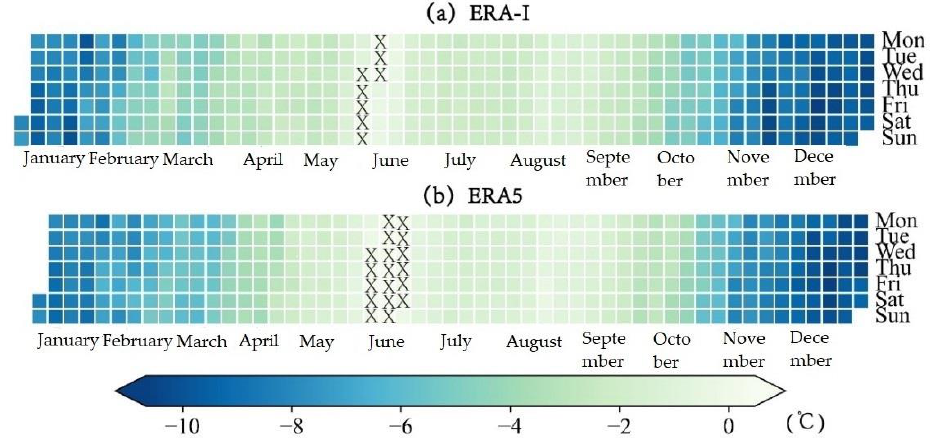
Figure 9. Calendar diagram of the daily Ts bias for ( a ) ERA-I and ( b ) ERA5 based on the multi-year mean. The symbol “X” denotes the days with positive biases.